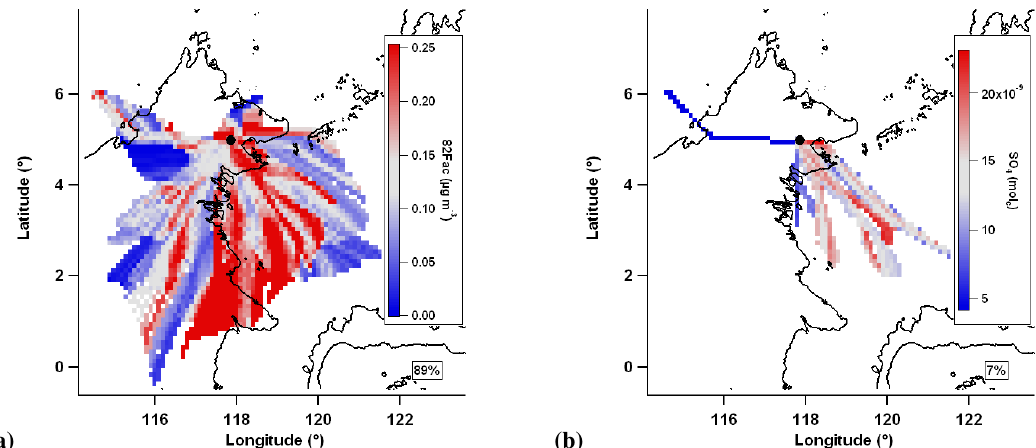
Fig. 14. Mean value maps of (a) 82Fac and (b) excess sulphate (defined as moles of charge of sulphate greater than moles of charge of ammonium plus 3 × 10 − 9 to account for spread of neutral values). Grey is median value, red is greater than median, blue is less than median and white denotes no data coverage. 36 h trajectories are used.